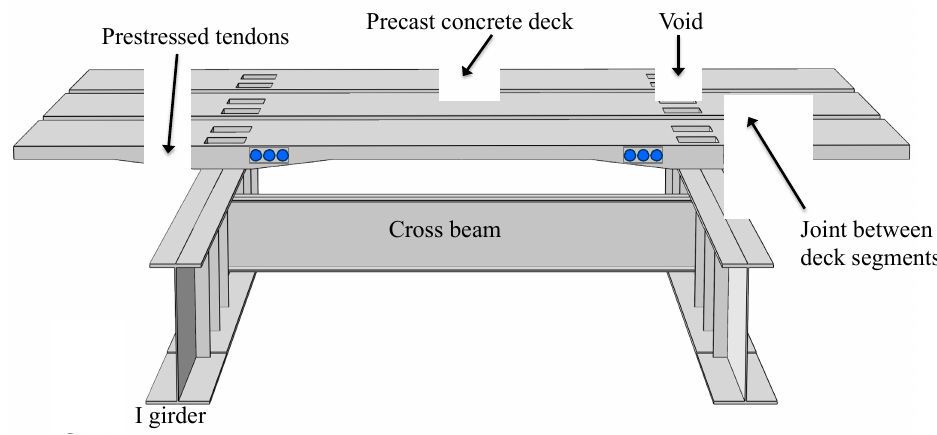
Figure 1 A continuous twin-I girder with prestressed precast concrete deck in the hogging region.